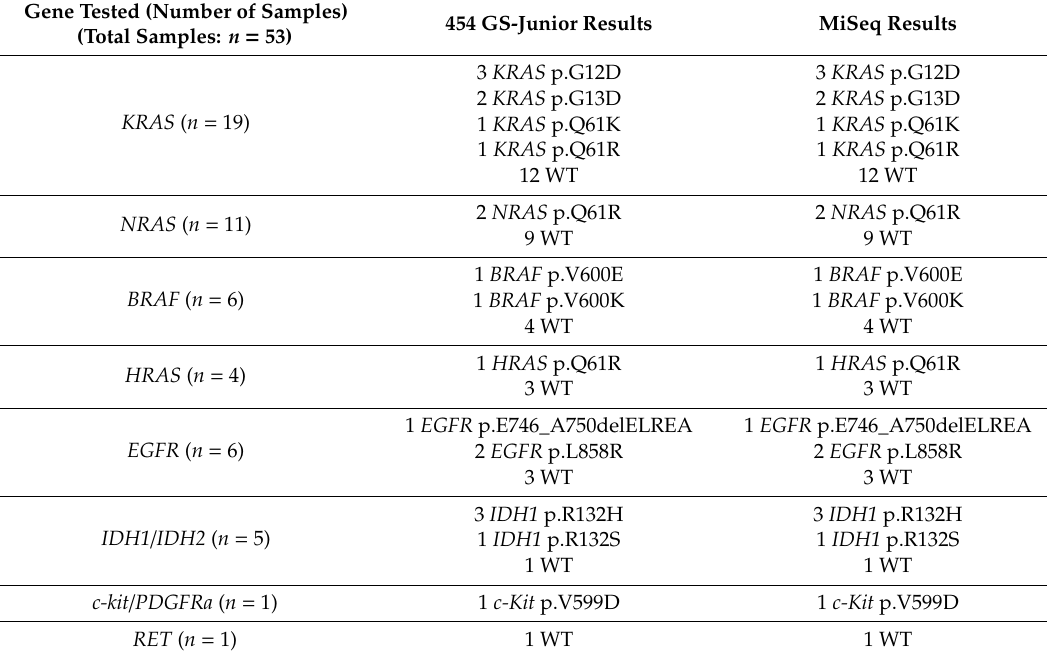
Table 1. Custom-designed multi-gene panel analytical validation of 53 samples using MiSeq and 454 GS-Junior sequencer. Gene Tested (Number of